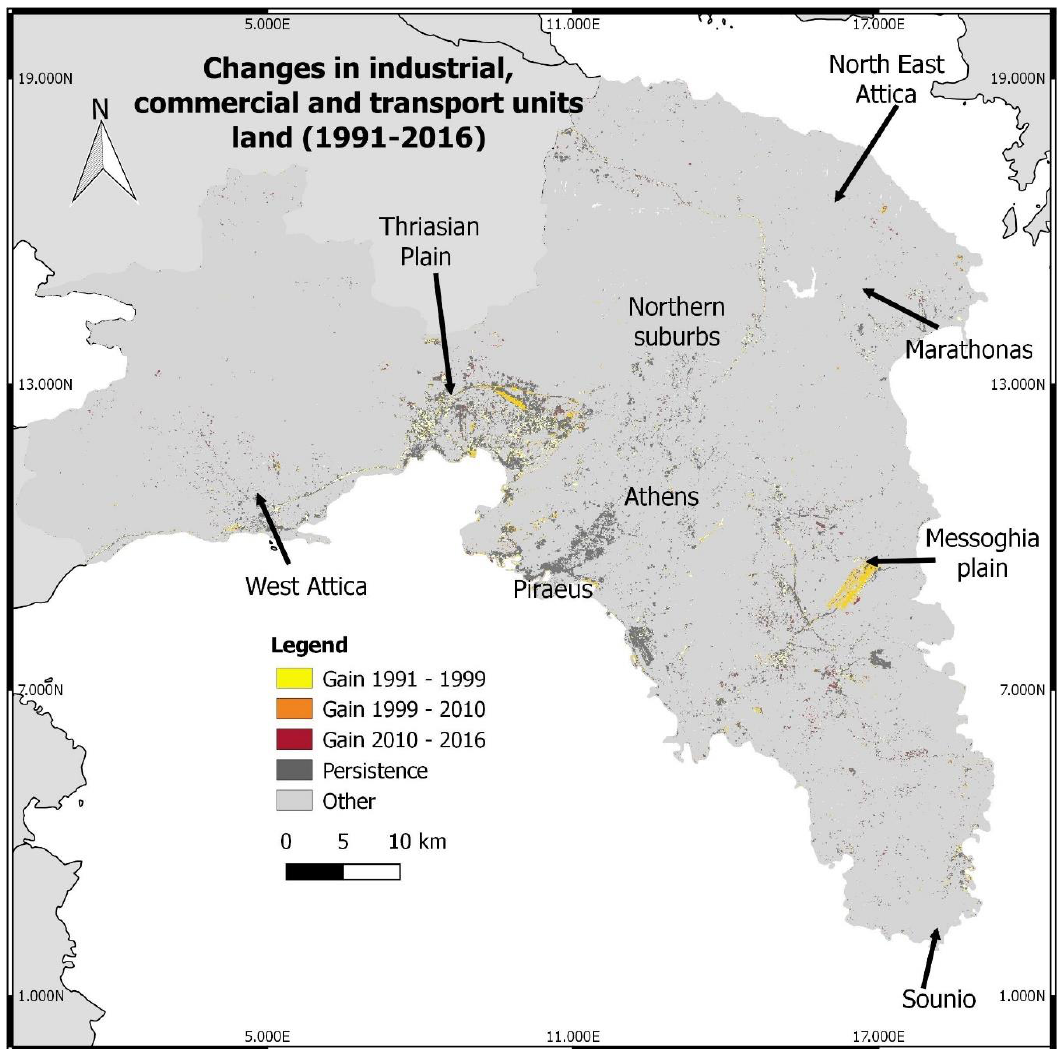
Figure 4. Industrial expansion observed between 1991 and 2016.